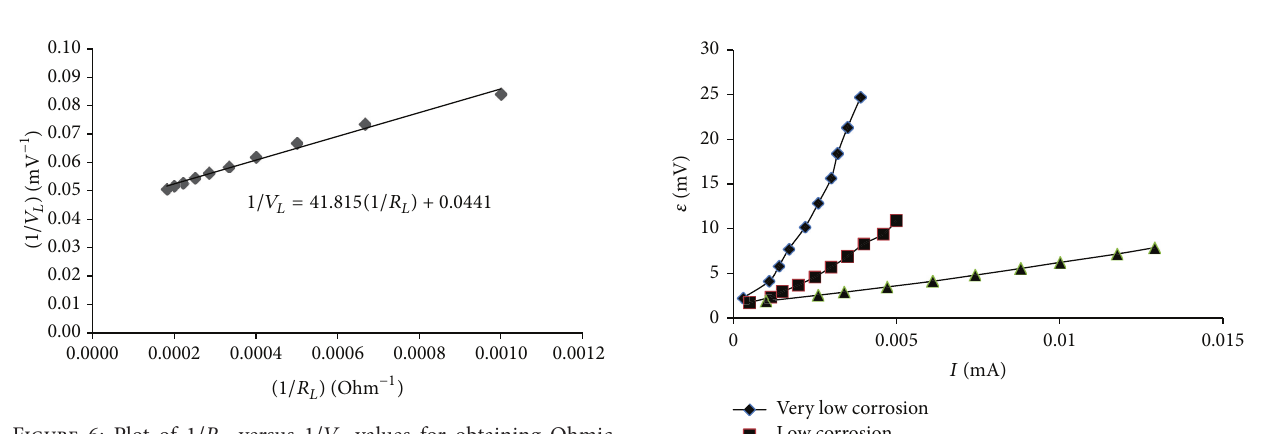
Figure 6: Plot of 1/𝑅 𝐿 versus 1/𝑉 𝐿 values for obtaining Ohmic resistance, 𝑅 .